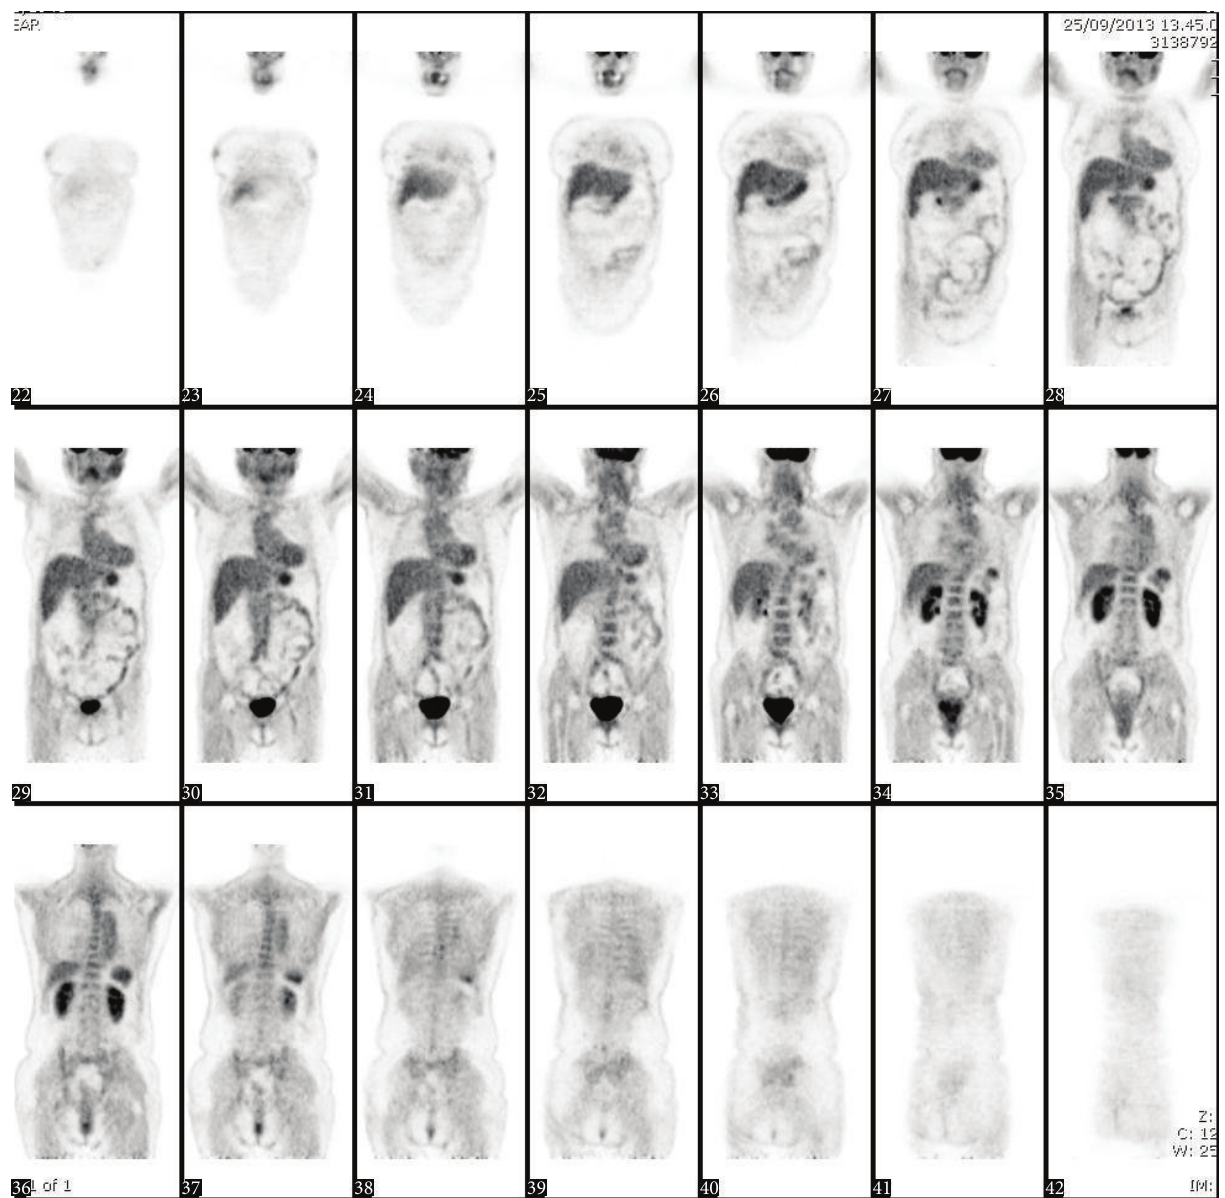
Figure 1: Positron emission tomography: increased uptake by the thoracic and abdominal aorta and aortic arch, indicating great vessels